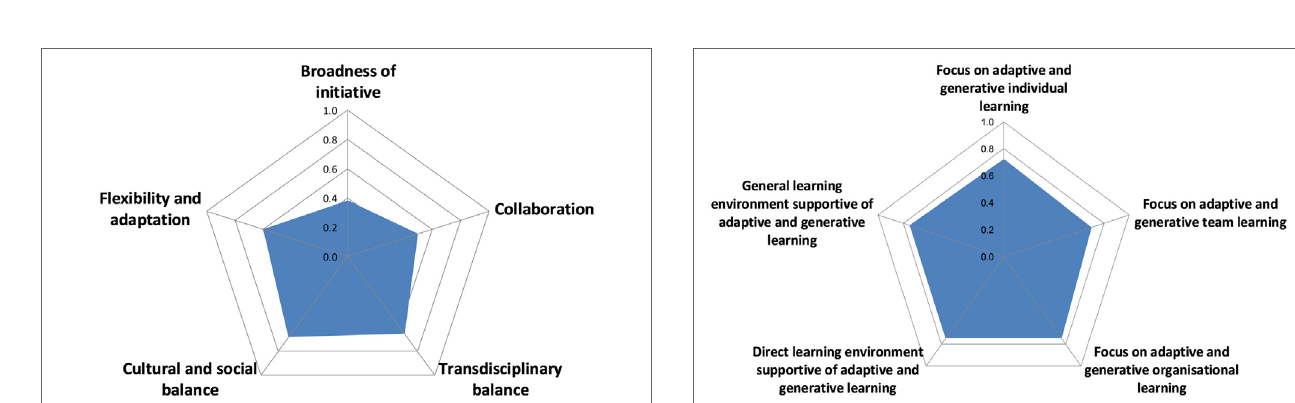
FigUre 7 | Assessment of One Health planning in the Southern African Centre for Infectious Disease Surveillance.